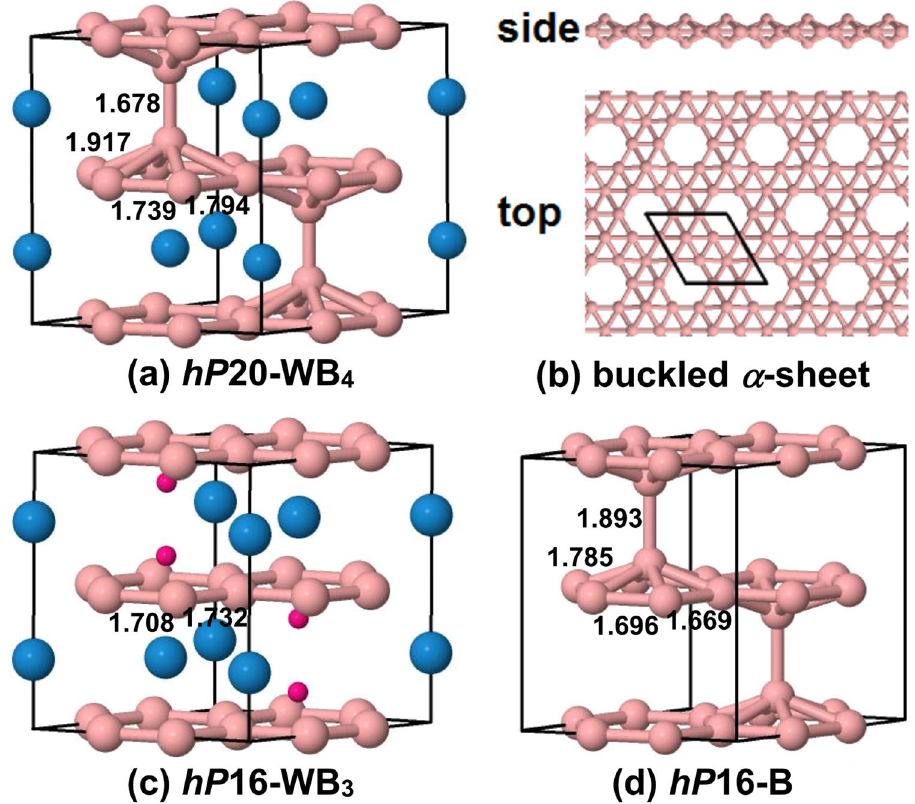
Figure 1. ( a ) The hP 20-WB 4 structure. The large and small spheres represent tungsten and boron atoms, respectively. ( b ) The side and top views of the buckled boron α -sheet present in the hP 20-WB 4 structure. ( c ) The hP 16-WB 3 structure. The small red dots indicate the position of the four extra boron atoms that are present in the hP 20-WB 4 structure. ( d ) The hP 16-B structure that is obtained by removing all of the tungsten atoms from hP 20-WB 4 . The numbers on the structures represent the nearest neighbor B–B distances and are given in